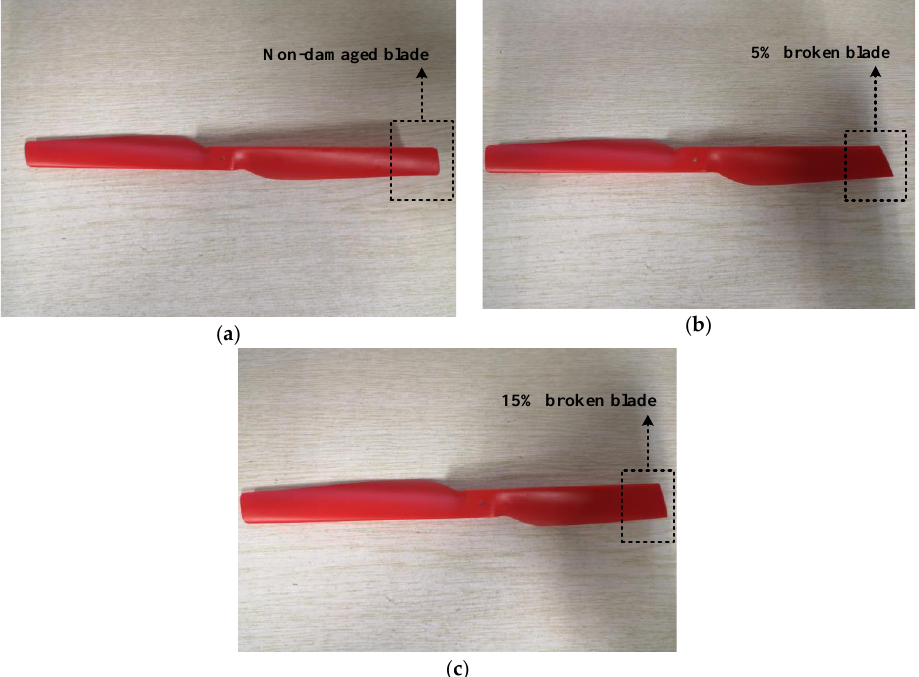
Figure 5. Quadcopter blades under three health states. ( a ) Non-damaged blade, ( b ) 5% broken blade, ( c ) 15% broken blade.